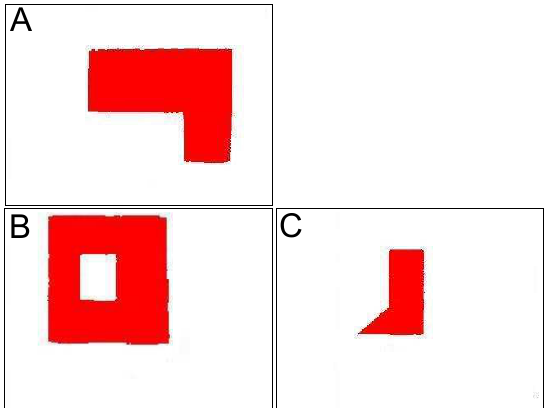
Figure 13. Preprocessed images of first building “II”, ( A )—top side, ( B )—front side, ( C )—right side.